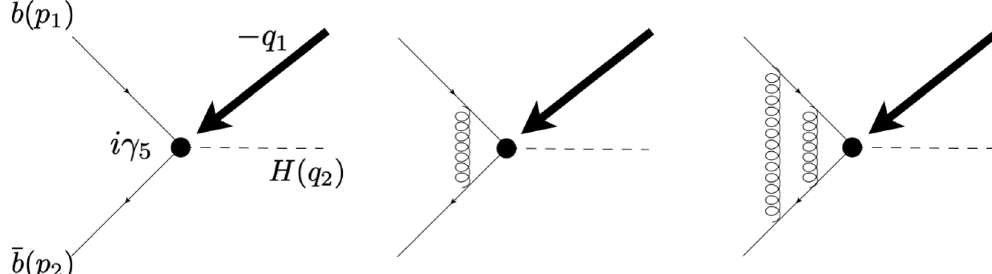
Figure 7 . Example diagrams at tree level, one-loop and two-loop corresponding to the right hand side of the Ward identity (3.10). The solid arrow indicates the insertion of the external momentum (cid:0) q 1 into the